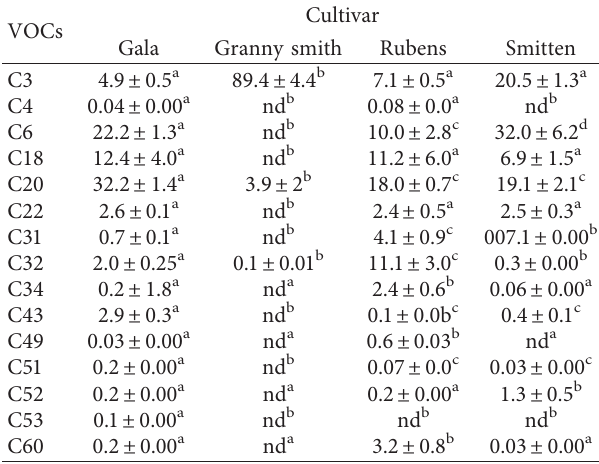
Table 2: Means of percentage relative abundance with standard error and significant differences ( P ≤ 0 . 05) of top 15 volatile compounds detected in the headspace of apple cultivars. Values expressed as percentage of the total volatiles detected per sample. Cultivar VOCs Gala Granny smith